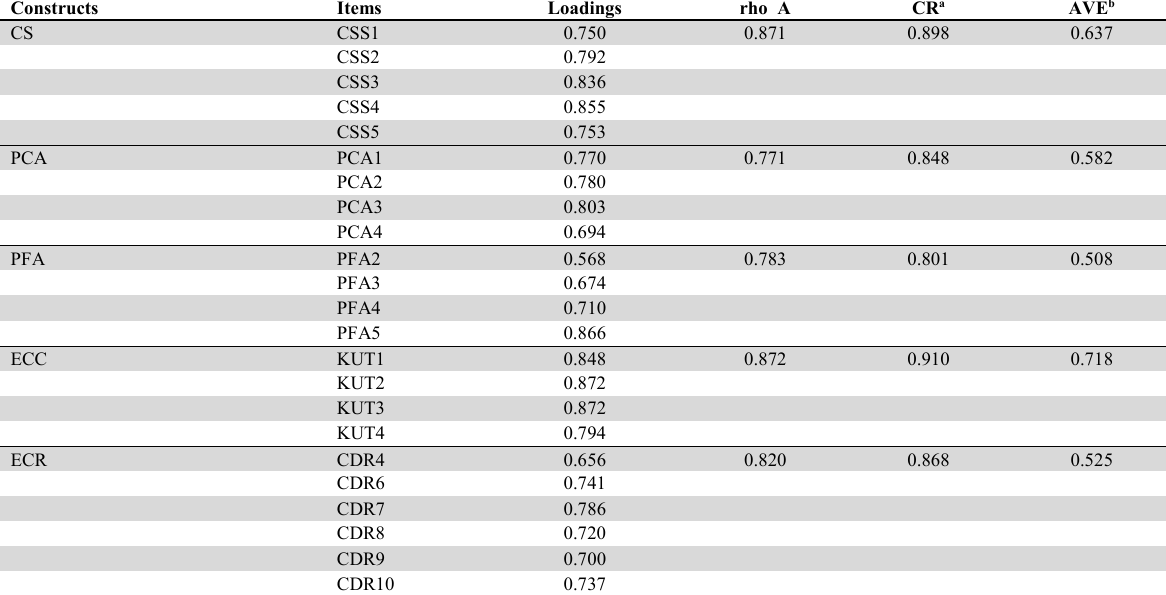
Loadings, Composite Reliability and Average Variance Extracted Constructs